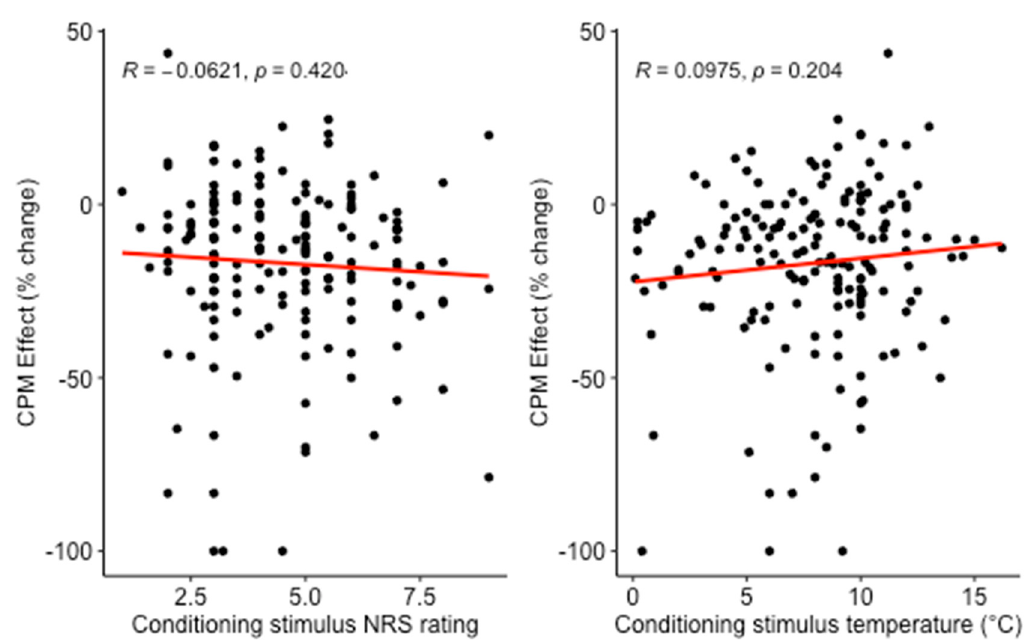
Figure 1. Relation between CPM effect and conditioning stimulus pain intensity or conditioning stimulus temperature in the cross-sectional analysis. Conditioning stimulus was hand immersion in cold water. More negative CPM effect designates a larger reduction of test pain rating by the conditioning stimulus.